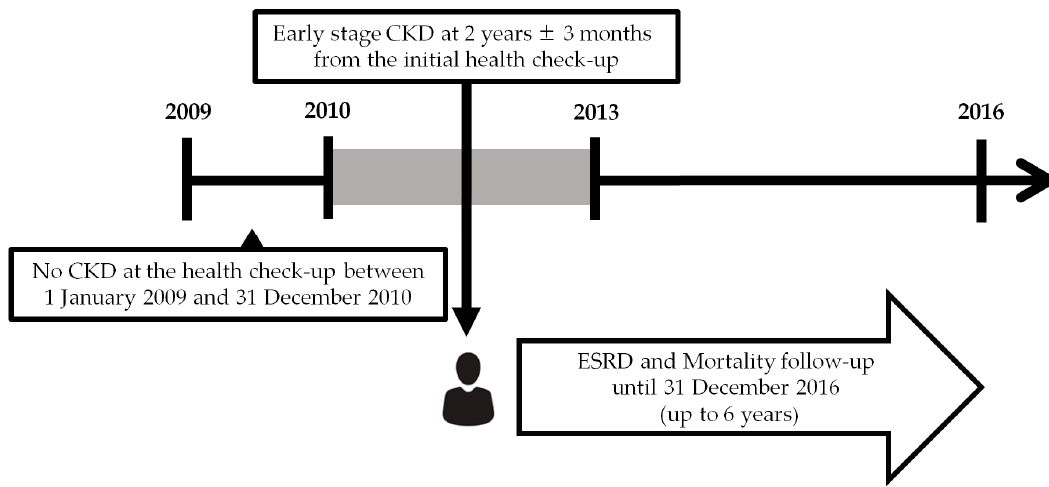
Figure 1. Study design.